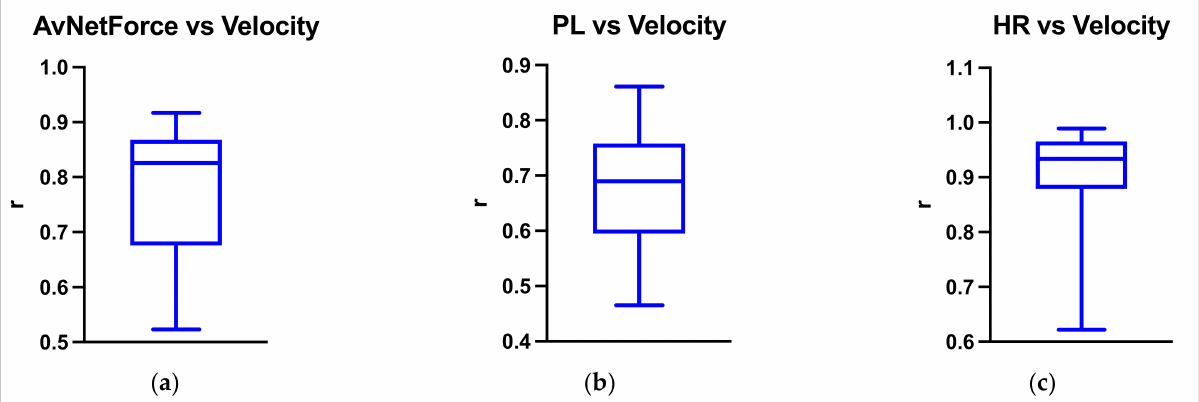
Figure 2. The figure reports the average and standard deviation (SD) of the correlation coefficient (r) between the velocity and the metrics considered. AvNetForce = average net force; PL = Player Load; HR = heart rate. ( a ) AvNetForce vs Velocity; ( b ) PL vs Velocity; ( c ) HR vs Velocity.